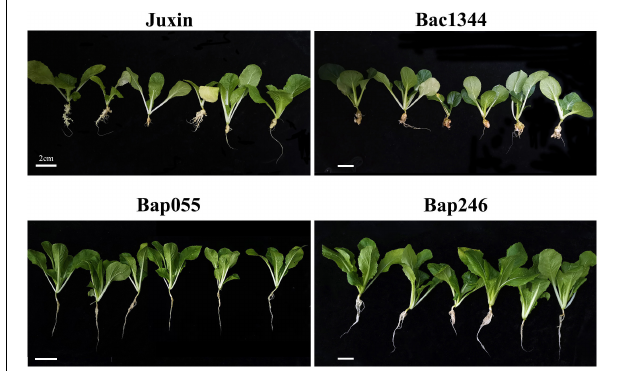
FIGURE 2 | Clubroot resistance assay on four genotypes. Three-day-old seedlings of each material were inoculated with resting spores of P. brassicae , and all plant roots were collected at 6 weeks and assayed for the clubroot